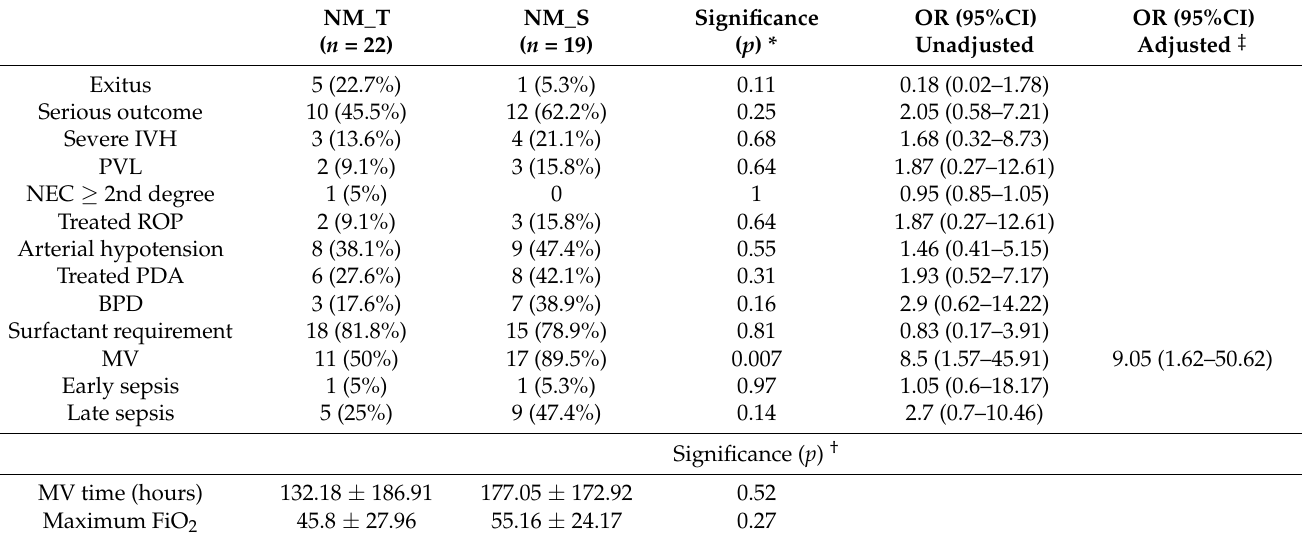
Table 5. Comparison of the non-matured population by place of birth.